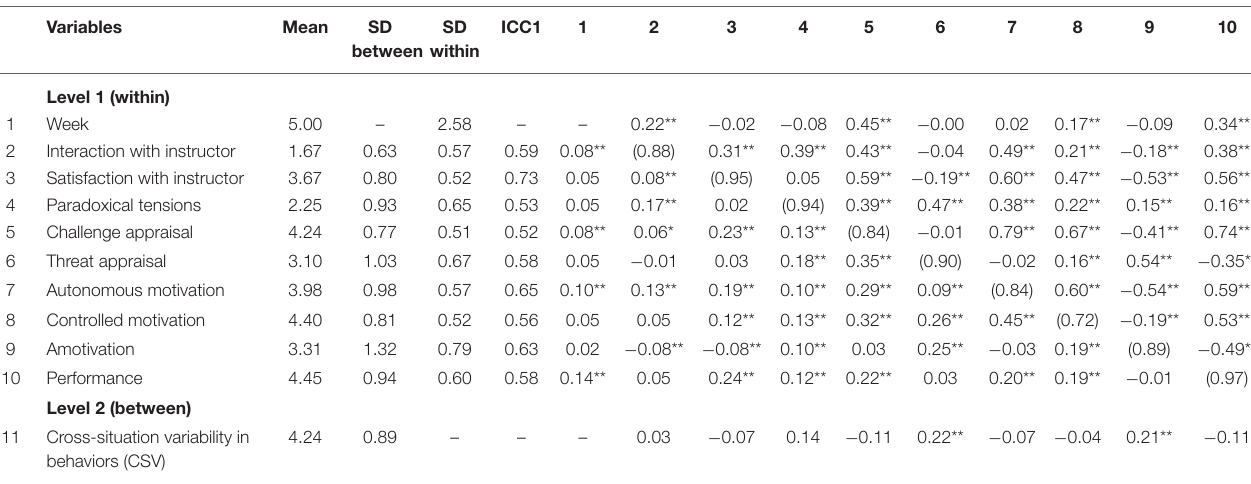
N = 178, observations = 1,355, Correlations below diagonal represent within-person associations. Correlations above diagonal represent between-person associations. Correlations among level 1 and level 2 variables are calculated by aggregating level 1 variable across weeks (N = 171). Reliabilities are reported in parenthesis. * p < 0.05, ** p < 0.01, Two-tailed test.